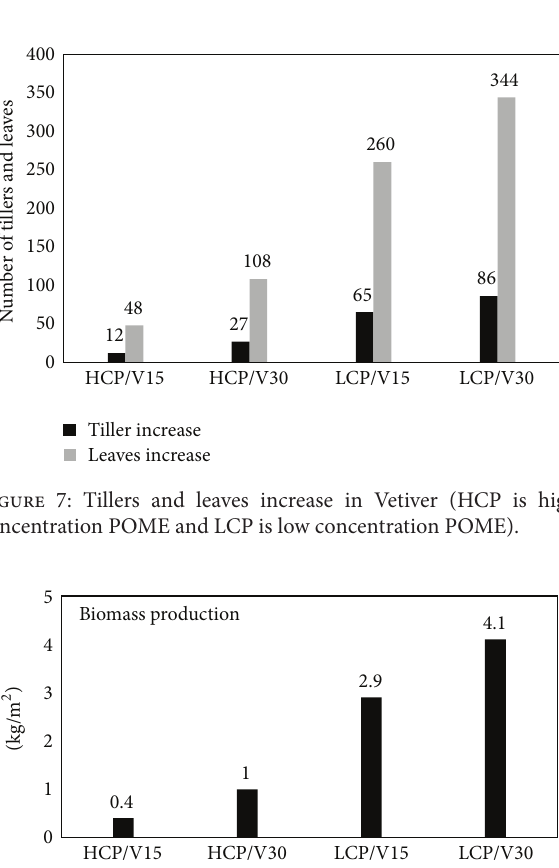
Figure 8: Biomass production of Vetiver (kgm −2 ) (HCP is high concentration POME and LCP is low concentration